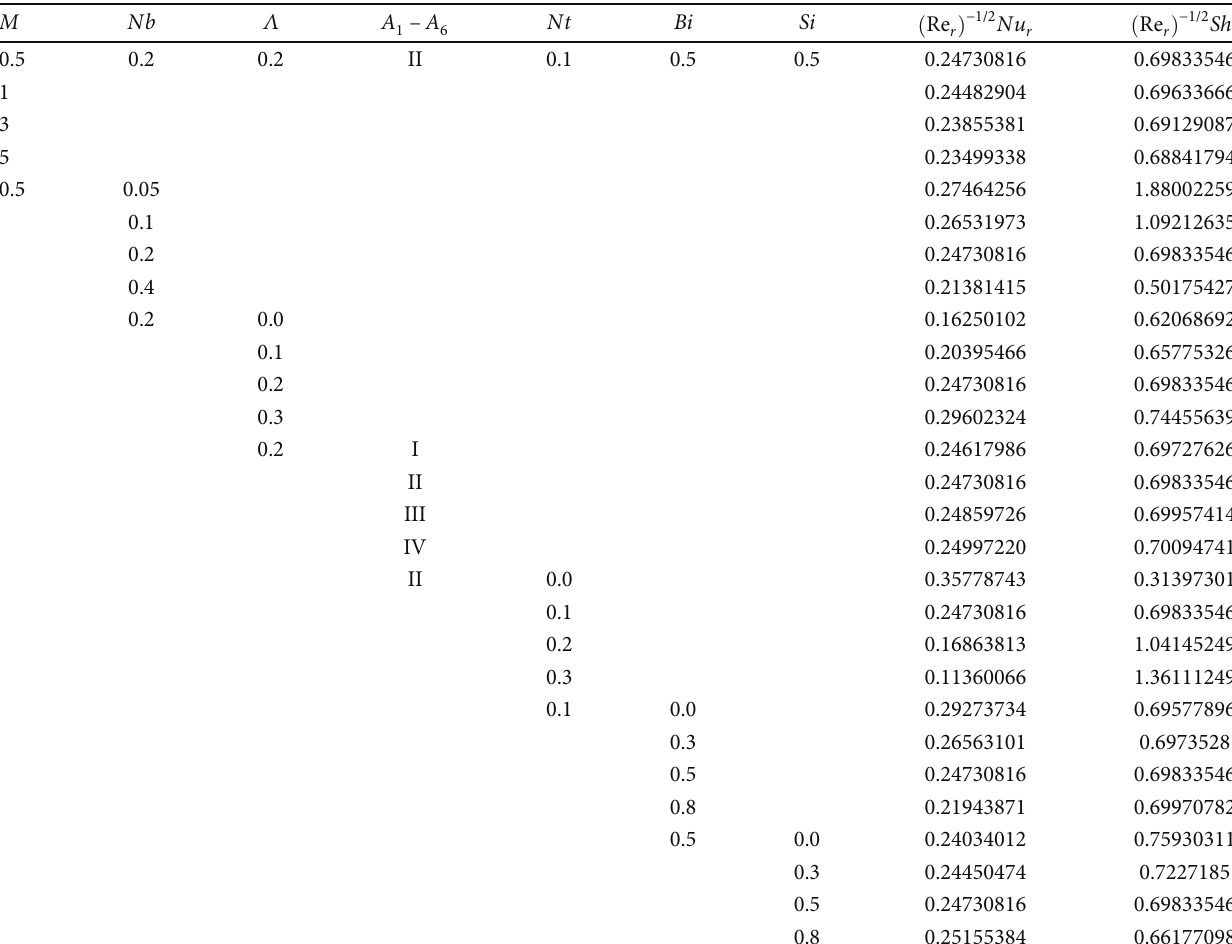
= 0 : 2 , α = 0 : 2 , δ = 0 : 1 , S = 0 : 1 , Sc = 0 : 5 , and K = 0 : 1 with node N = 50 0 t c